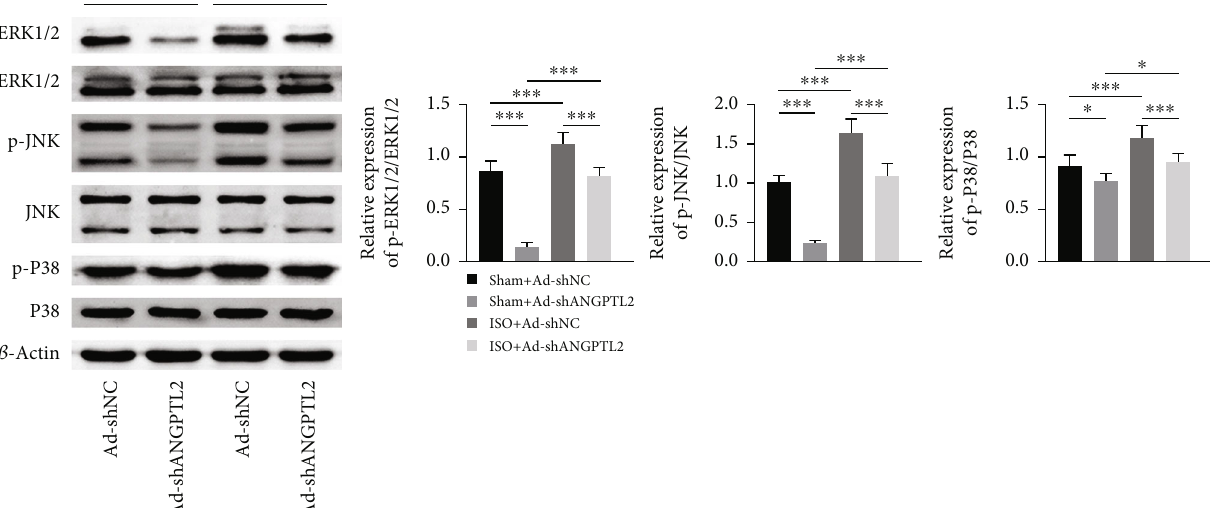
Figure 5: Downregulation of ANGPTL2 inhibited iso fl urane-induced MAPK signaling pathway in mice. Western blotting was carried out to measure p-ERK1/2, ERK1/2, p-JNK, JNK, p-P38, P38, and β -actin protein levels in brain tissues. n = 6 . ∗ p < 0 : 05 ; ∗∗∗ p < 0 : 001